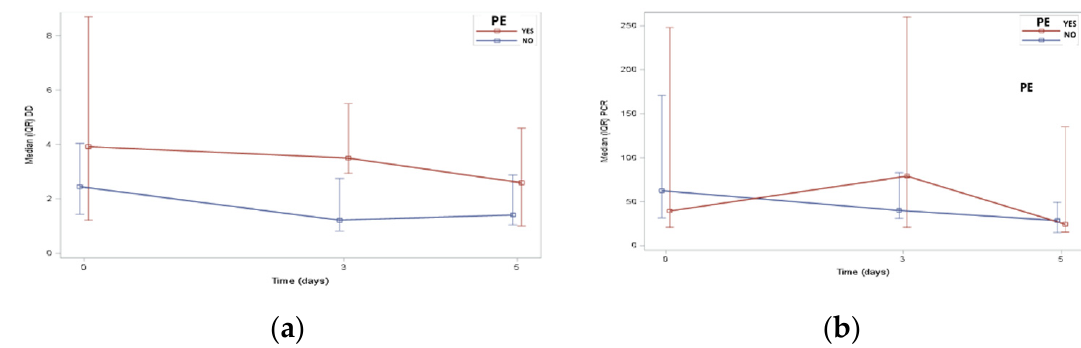
Figure 2. Schemes following biomarker evolution during hospitalization: ( a ) D-dimer evolution curve according to groups, and ( b ) C-reactive protein evolution curve according to groups.